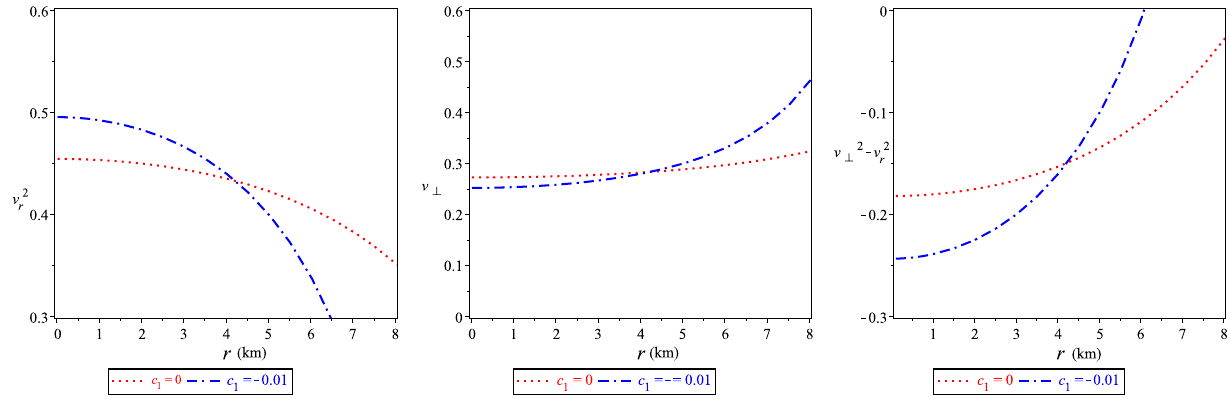
Fig. 5 Gradients of density, radial, and transverse pressures. All figures show that the gradients of the components of the energy–momentum tensor are negative consistent with those of a real stellar